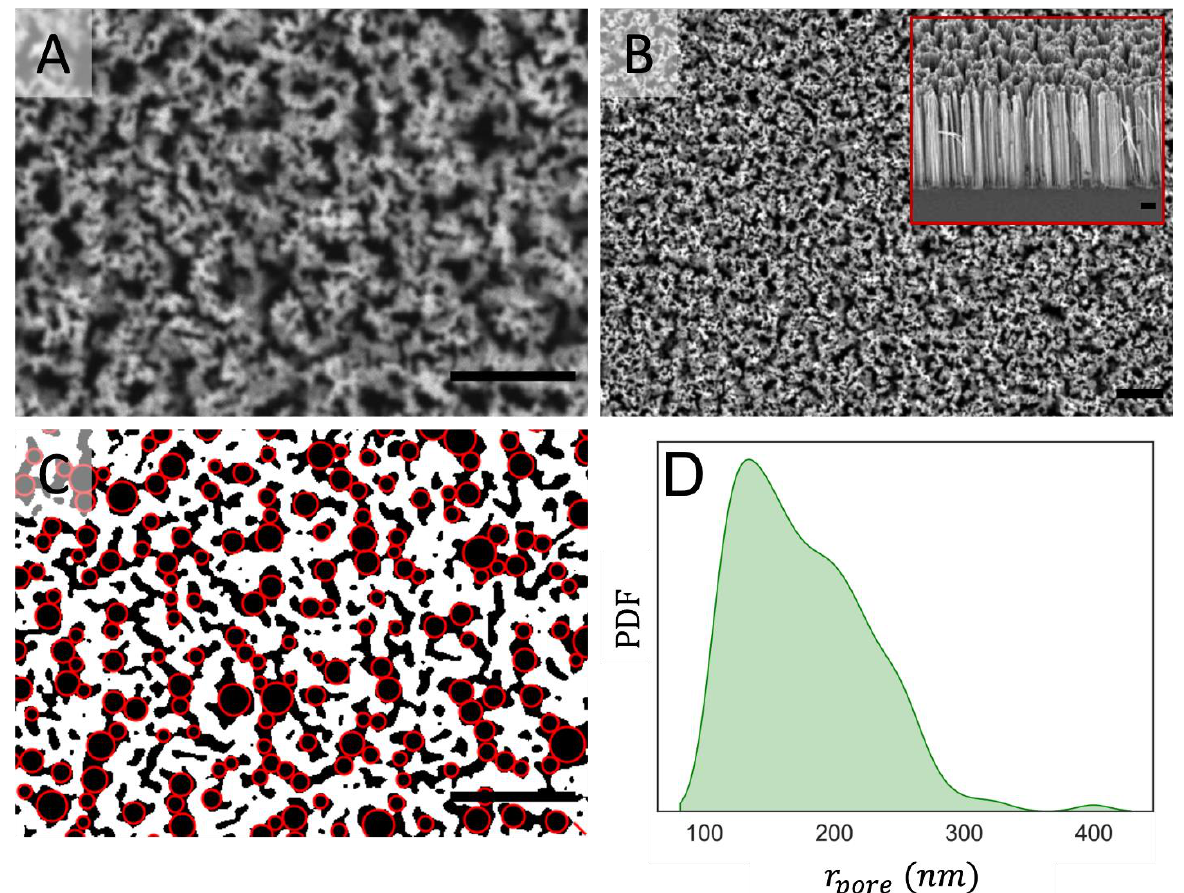
Figure 3. Scanning electron microscopy (SEM) data for vertically aligned silicon nanowire arrays: ( A , B ) Top-view SEM images at different magnifications, inset in B displays SEM side view of the SiNW surface; ( C ) Representative segmentation mask generated from SEM images, showing silicon nano-wire arrays (white), pores (black) and inscribed circumferences (red) used to calculate the pore size; ( D ) Probability density function of the pore radius for SiNW surfaces weighted by the pore area. Scale bars are 2 µm.